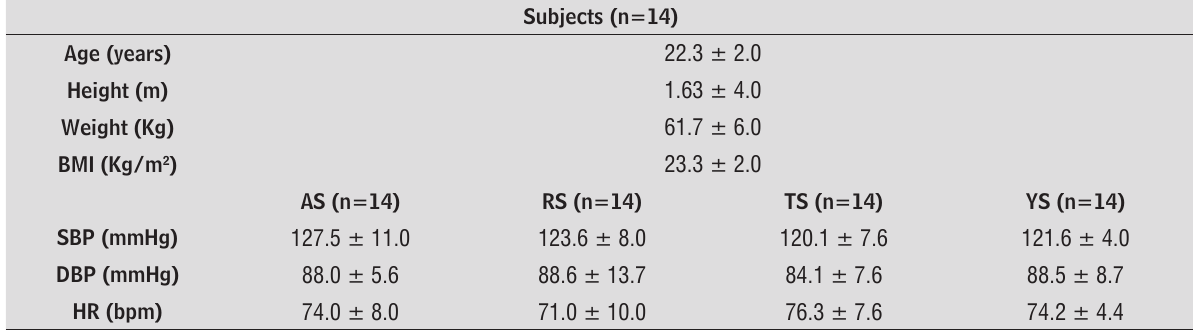
Table1 - Anthropometric and hemodynamic characteristics of